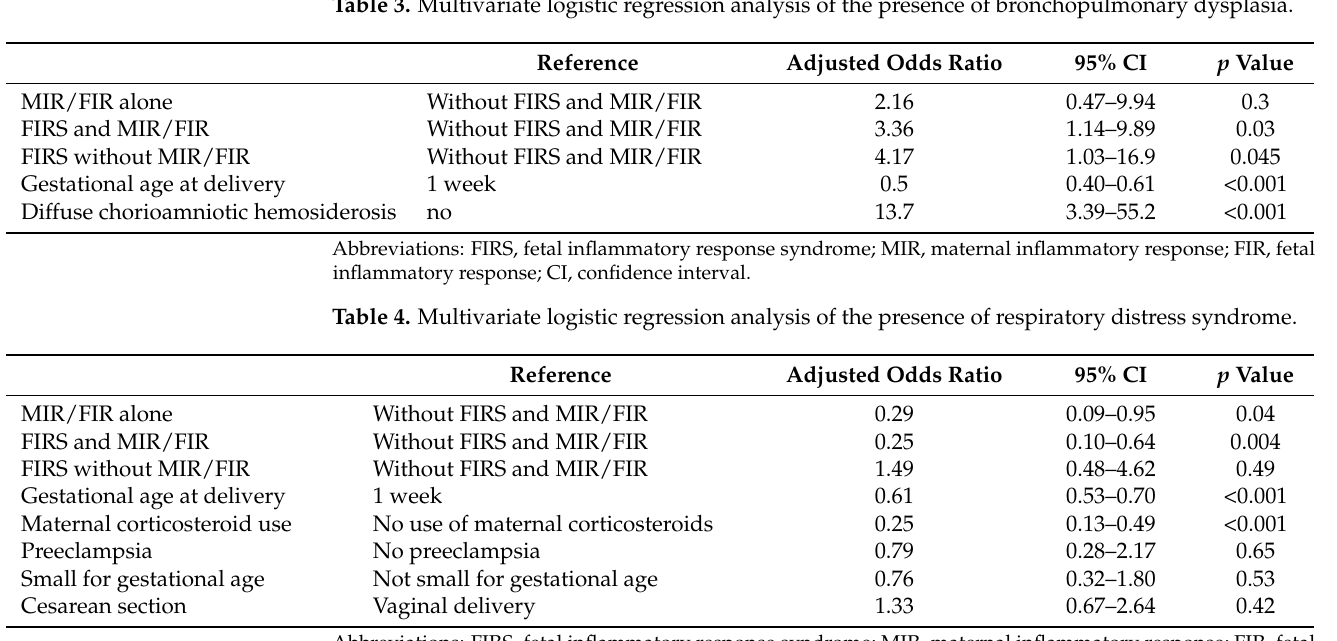
Table 3. Multivariate logistic regression analysis of the presence of bronchopulmonary dysplasia.